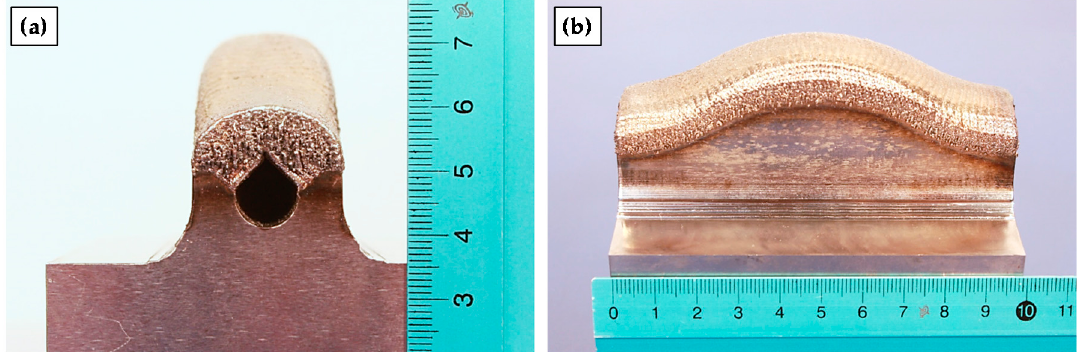
Figure 16. ( a ) Front; ( b ) lateral views of the resulting part after LMD.